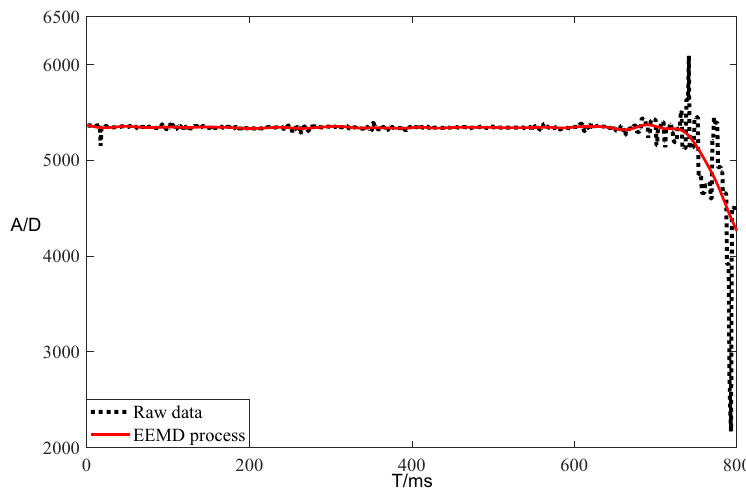
Figure 15. The rendering of the EEMD filter.